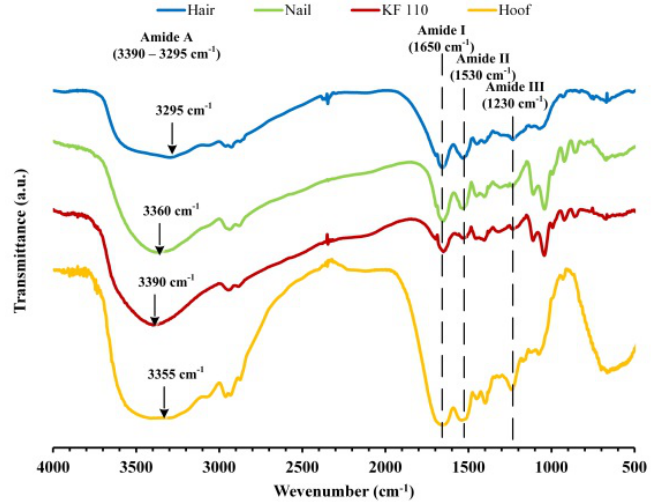
Figure 5. Fourier transform infrared spectroscopy (FTIR) spectra of human hair, nail, KF-110 and bovine hoof samples.